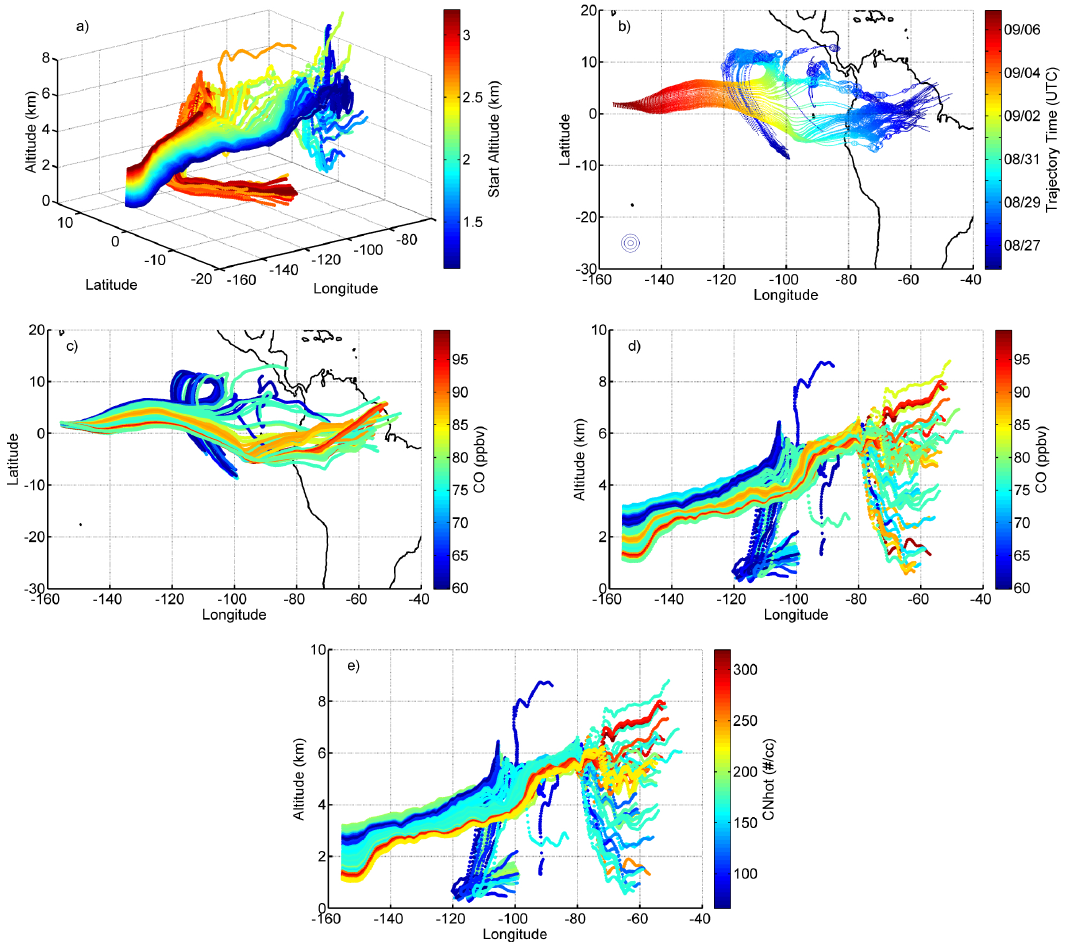
Fig. 5. Back trajectories for RF14 color coded with (a) aircraft start altitude for 3-D trajectories, (b) date on latitude-longitude projec- tion with HYSPLIT precipitation expressed in marker size. The blue circles in the lower left corner exemplify precipitation intensities of 1/5/10mmh − 1 . Plot (c) shows measured CO on latitude-longitude projection, (d) CO on vertical projection and (e) CNhot on vertical